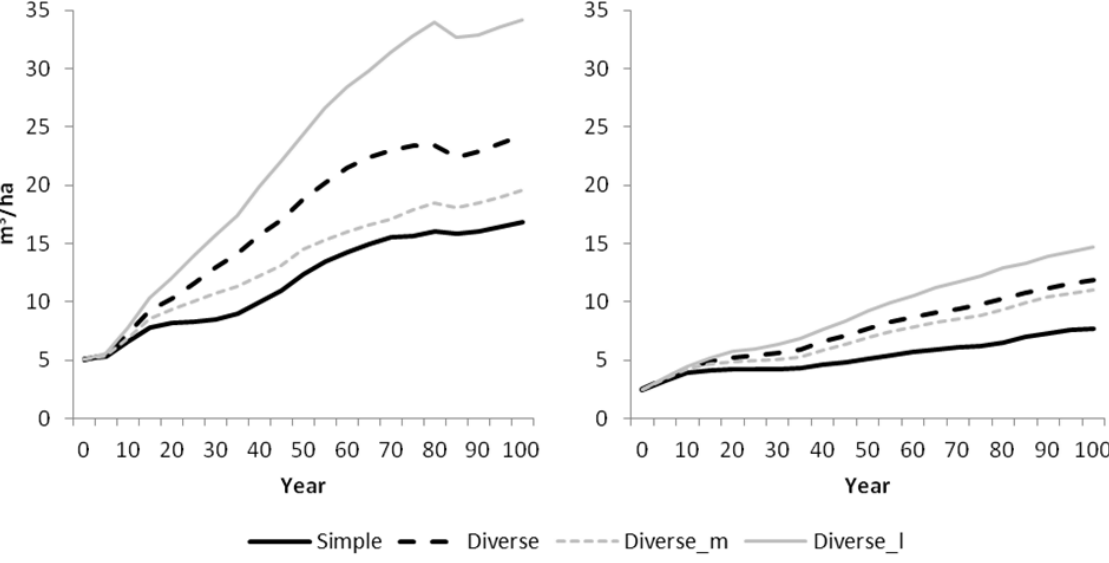
Figure 10. Fresh standing and lying deadwood (m 3 /ha) in Hässleholm ( left ) and Vilhelmina ( right ), for the Simple and Diverse scenarios, as well as the more intensive (Diverse_m) and less intensive (Diverse_l) variations of the Diverse